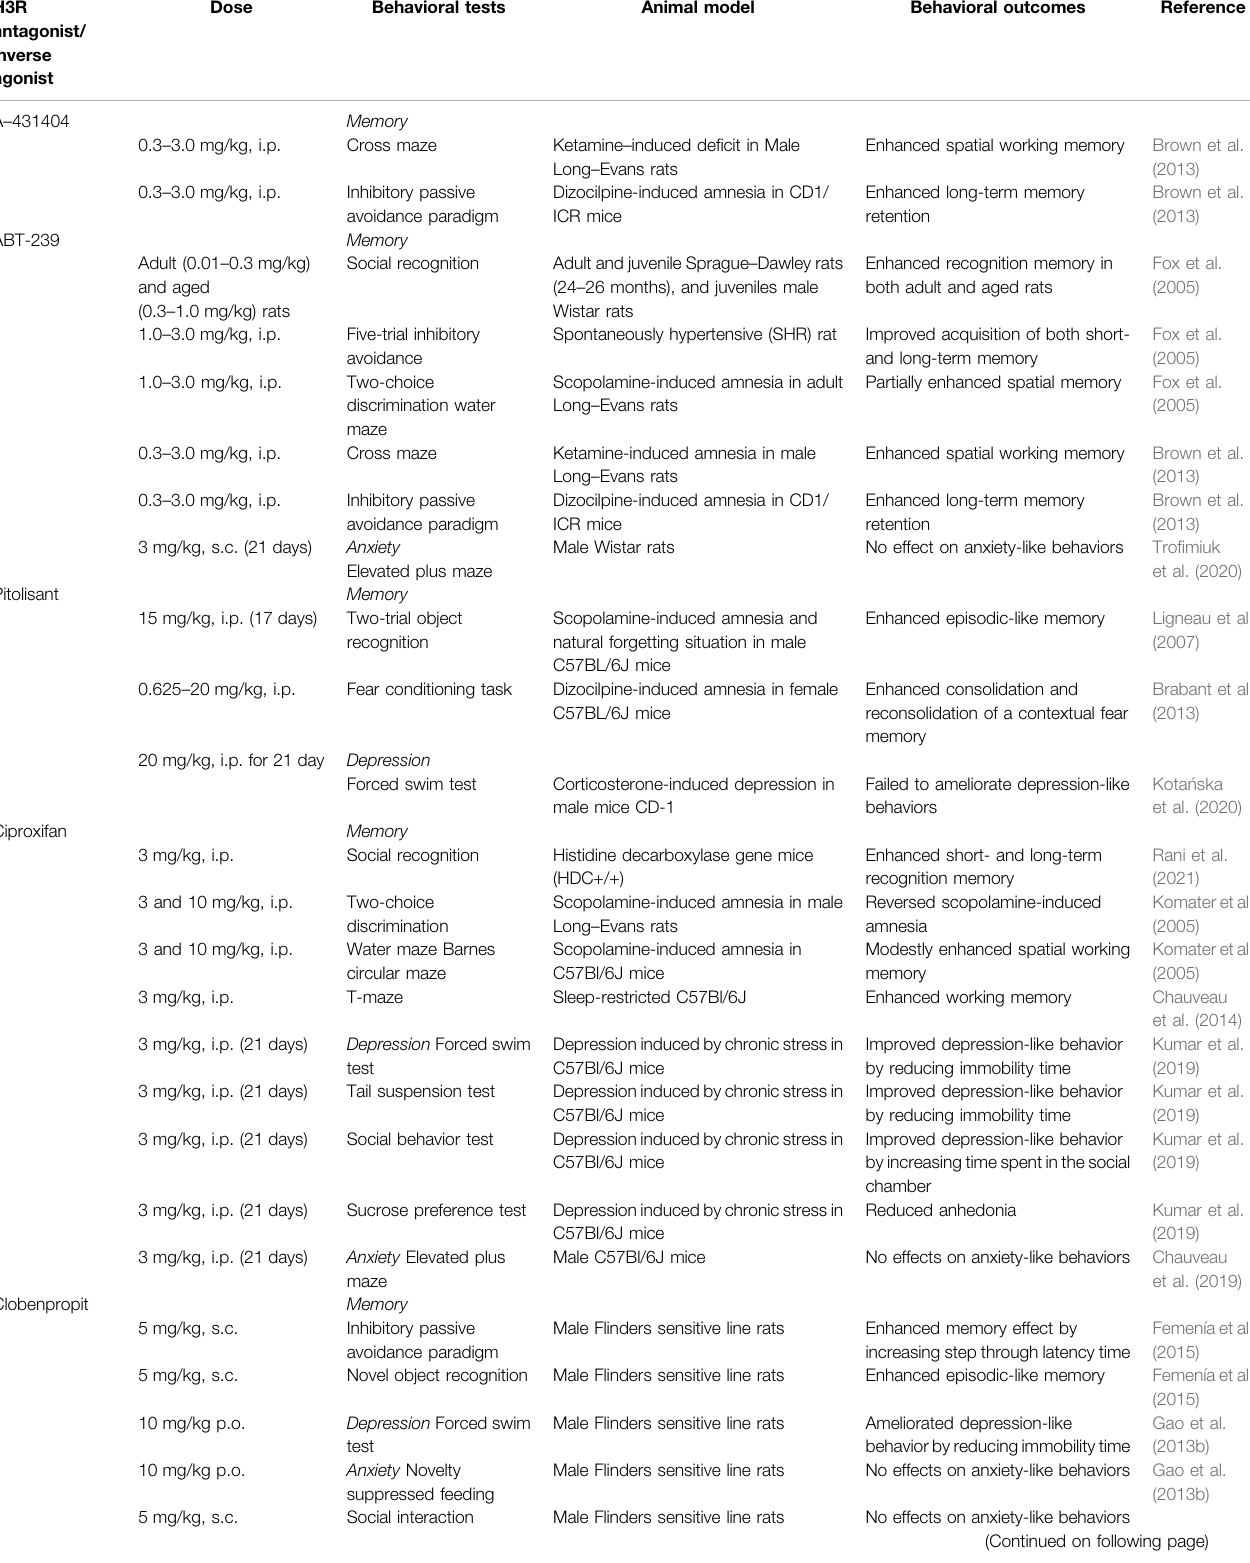
TABLE 1 | Several H3R antagonists/inverse agonists and their observed effects in preclinical models of memory impairment, depression, anxiety, and sleep – wake cycle disorder. H3R antagonist/ inverse